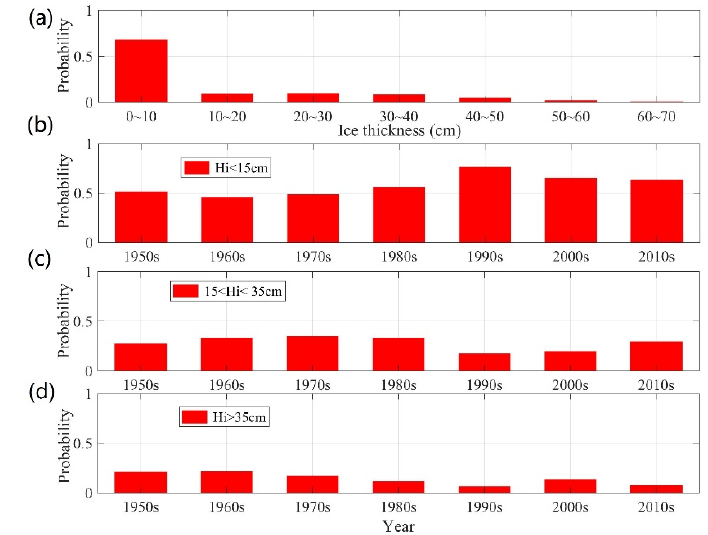
Figure 11. ( a ) Probability of ice thickness (grouped every 10 cm) distribution in the winter of 1951/1952–2017/2018. The probability of ice thickness in different thickness categories between 0 and 15 cm in ( b ), between 15 and 35 cm in ( c ) and larger than 35 cm in ( d ).